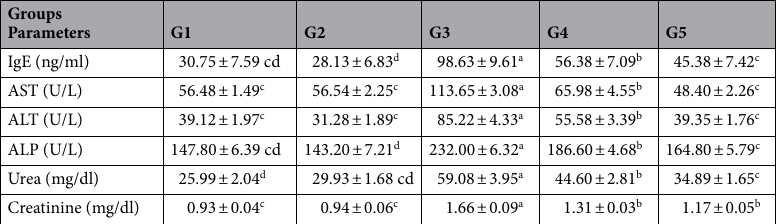
Table 4. Effect of thymoquinone supplementation and/or malathion inhalation on serum biochemistry of rats. Values are expressed as mean ± standard errors. Means in the same row (a-b) with different subscript letters significantly differ at (p ≤ 0.05). AST aspartate aminotransferase, ALT alanine aminotransferase, ALP alkaline phosphatase. G1 = control group, G2 = thymoquinone group (50 mg/kg body weight), G3 = malathion group G4 = malathion inhalation + thymoquinone 25 mg/kg body weight, and G5 = malathion inhalation + thymoquinone 50 mg/kg body